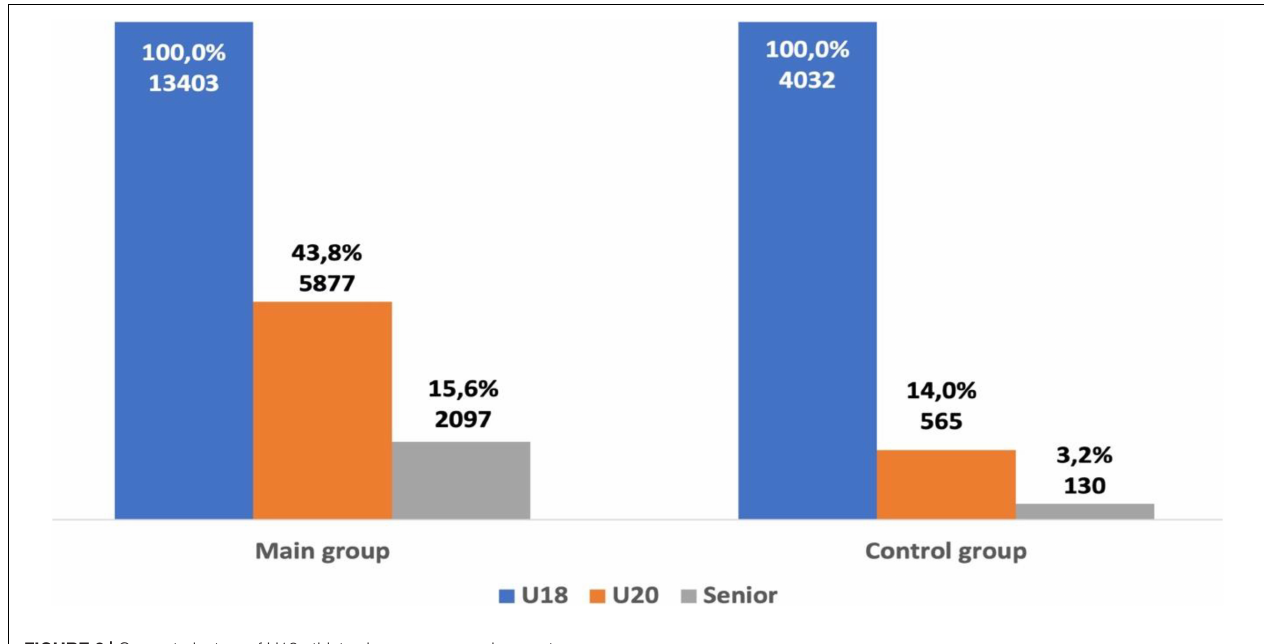
FIGURE 2 | Career trajectory of U18 athletes in group one and group two.